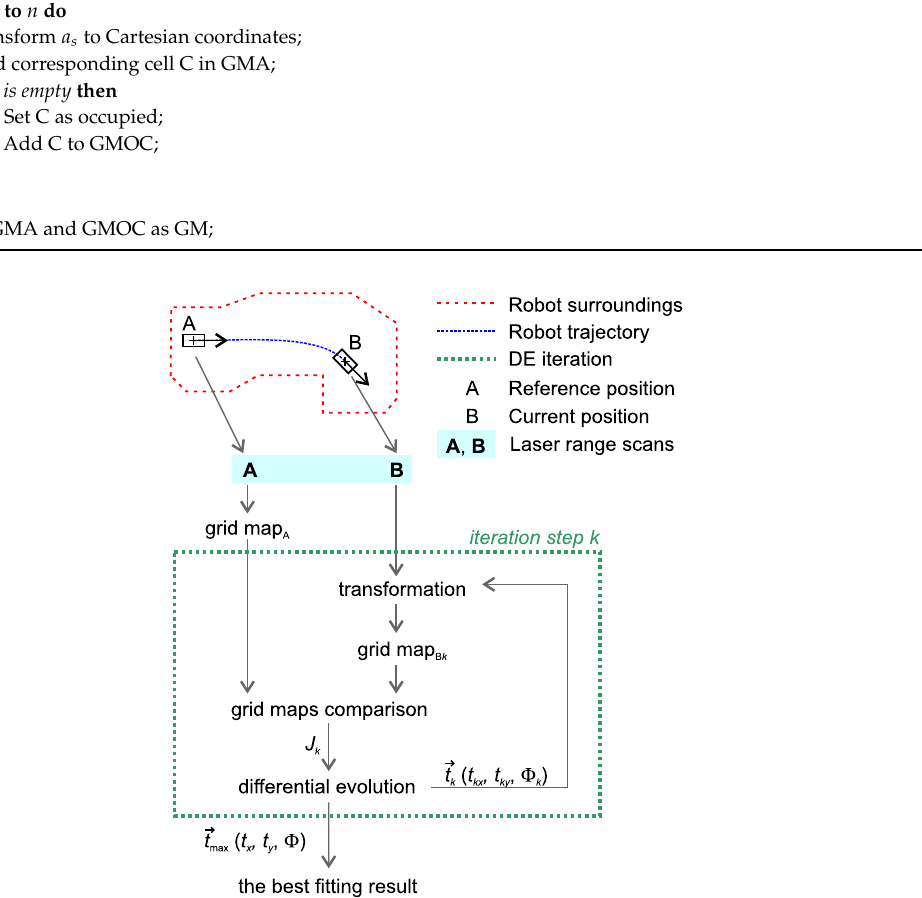
Figure 4. Description of the proposed algorithm: laser range reading and DE-based scan